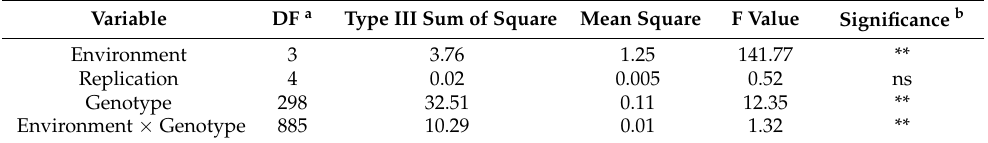
Table 1. Analysis of variance for spike-layer uniformity across the four environments.